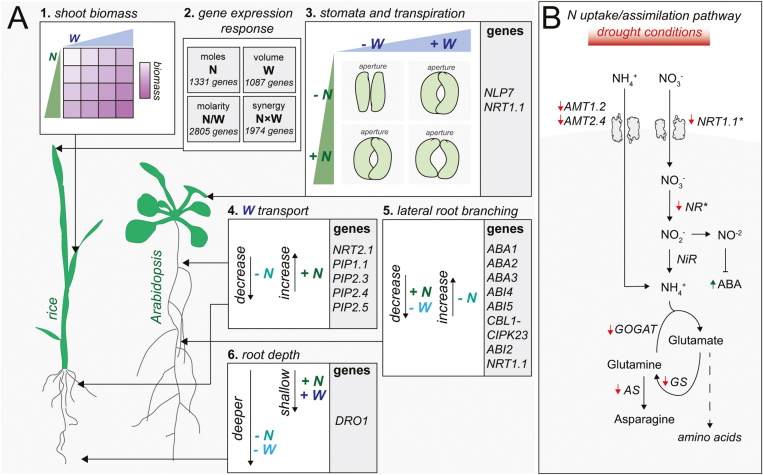
N and W doses combine to impact plant physiology and gene regulation. (A) (A.1) N and W combine to have a synergistic interaction on shoot biomass in rice (Swift et al., 2019). (A.2) A single integrated study of N and W dose responses performed in rice reveals plant responses to N dose as (moles) or N concentration (N/W), which exhibit distinct transcriptomic responses. Additionally, the dose of N and W also exhibits a synergistic effect (N×W) on gene expression responses and phenotypes (Swift et al., 2019). (A.3) Stomatal opening and transpiration are influenced by N and W availability (Shi et al., 2014). NLP7 and NRT1.1/NPF6.3 are genes that mediate the role that N plays in stomatal aperture in Arabidopsis (Guo et al., 2003; Castaings et al., 2009). (A.4) Hydraulic conductivity is modulated by soil N and the N transporter NRT2.1, and through regulation of expression of PIP aquaporins in Arabidopsis and rice (Li et al., 2016). (A.5) Drought and high N have a negative effect on root branching in Arabidopsis (Signora et al., 2001; De Smet et al., 2003). Genes involved in ABA biosynthesis and sensing can mediate the repressive effect of N on root branching in Arabidopsis (Signora et al., 2001). Additionally, the CBL1–CIPK23–NRT1.1/NPF6.3–ABI2 regulatory module integrates N and W levels to regulate lateral root branching in Arabidopsis (Léran et al., 2015). (A.6) Root systems growing deeper to forage for W also assist with N uptake under low W and low N conditions (Lilley and Kirkegaard, 2011). DRO1 governs rice cell elongation, leading to expansive roots that promote N and W uptake in rice (Arai-Sanoh et al., 2014). (B) Drought conditions negatively impact N uptake and N metabolism gene expression in Arabidopsis (red arrows) (Goel and Singh, 2015; Duan et al., 2016). Mutating genes (indicated by *) in N metabolism improves drought tolerance in Arabidopsis (Guo et al., 2003). NR activity contributes to NO levels that inhibit ABA activity in Arabidopsis (Lozano-Juste and León, 2010; Castillo et al., 2015).